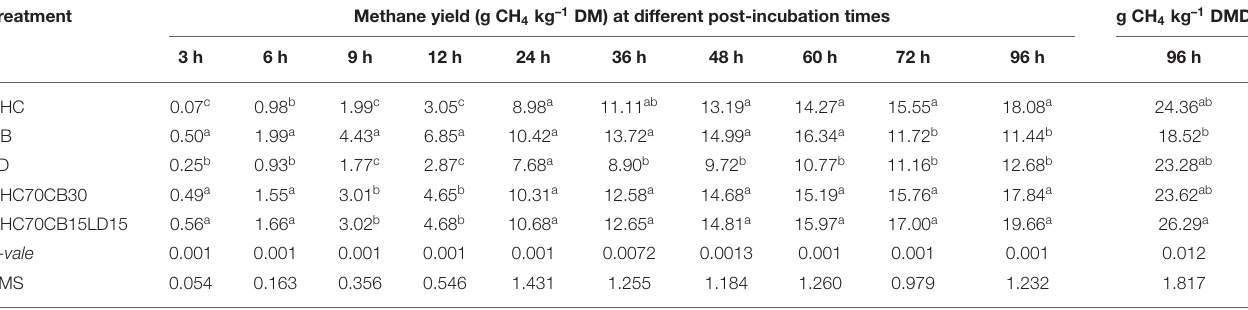
TABLE 7 | Methane yield from UHC, CB, LD, and their mixed diets. Treatment